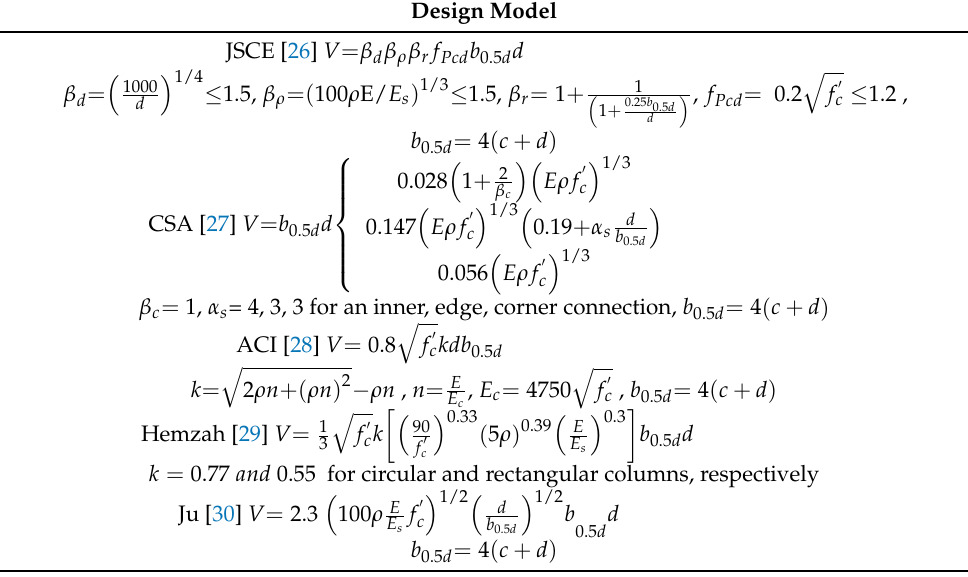
Table 1. Selected slab-column strength